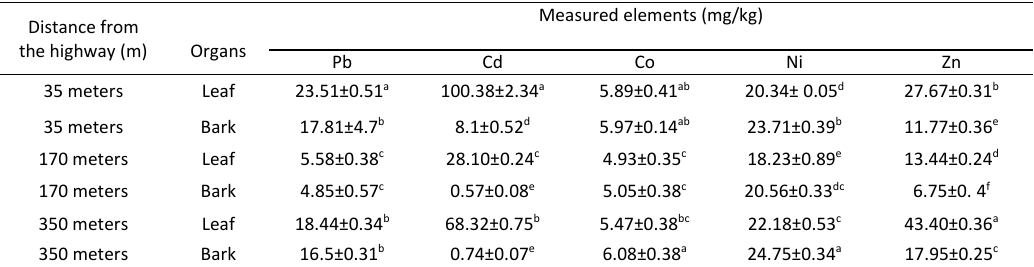
Table 4. The effect of distance from the highway within the bark and leaves of Fraxinus excelsior